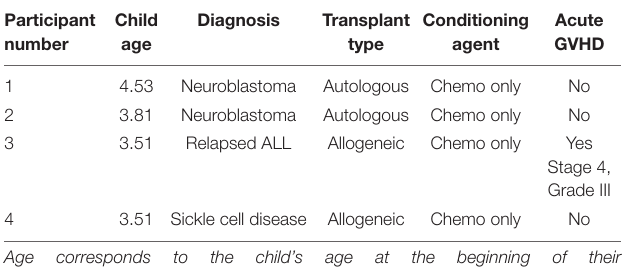
TABLE 1 | Child demographics, diagnosis, and treatment. TABLE 2 | Active music engagement (AME) intervention components and theoretical